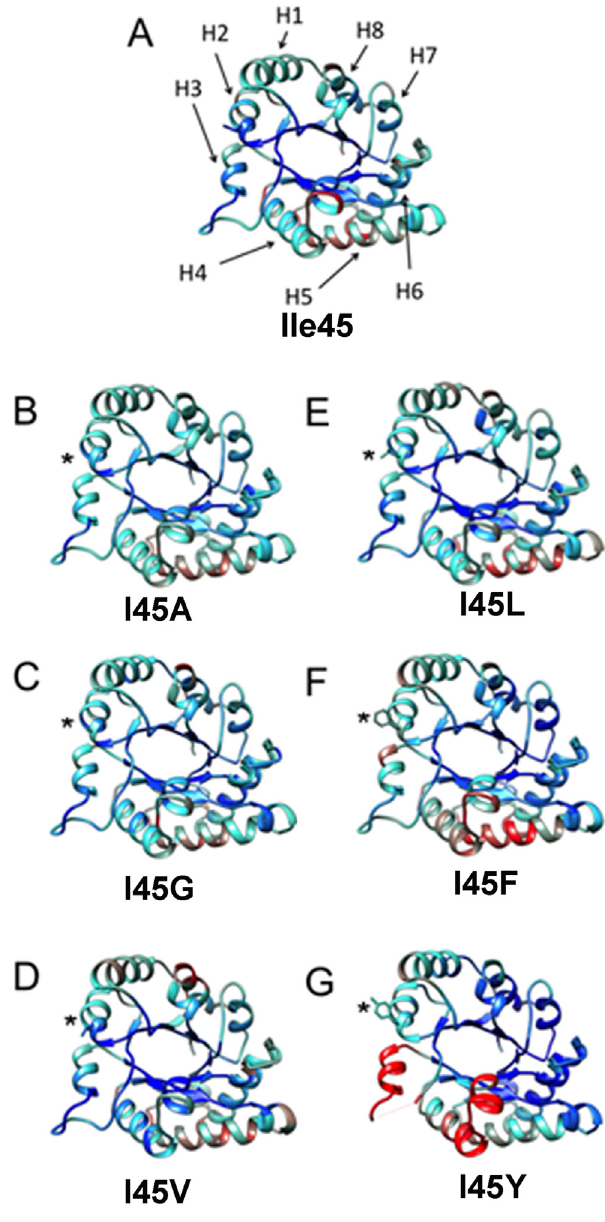
Fig 7. Comparison of the normalized B-factor values of TvTIM1 and mutants at residue 45. Crystal structure of the wild-type enzyme and the mutants ribbons indicating the variation of the normalized B-factors (A) TvTIM1 structure, the mean value of the normalized B-factor is represented in cyan, the lower value is blue, and the highest B-factor value is red. (B) I45G, (C) I45A, (D) I45V, (E) I45L, (F) I45F and (G) I45Y. The position of the eight α -helices of the ( β - α ) 8 barrel fold is indicated by arrows (H1 – H8) on TvTIM1 structure